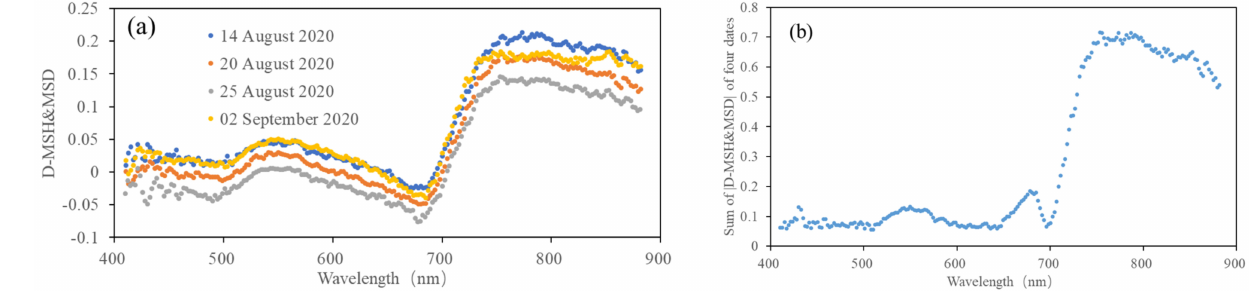
Figure 5. ( a ) D-MRH&MRD and ( b ) sum of |D-MRH&MRD| at each band for the four